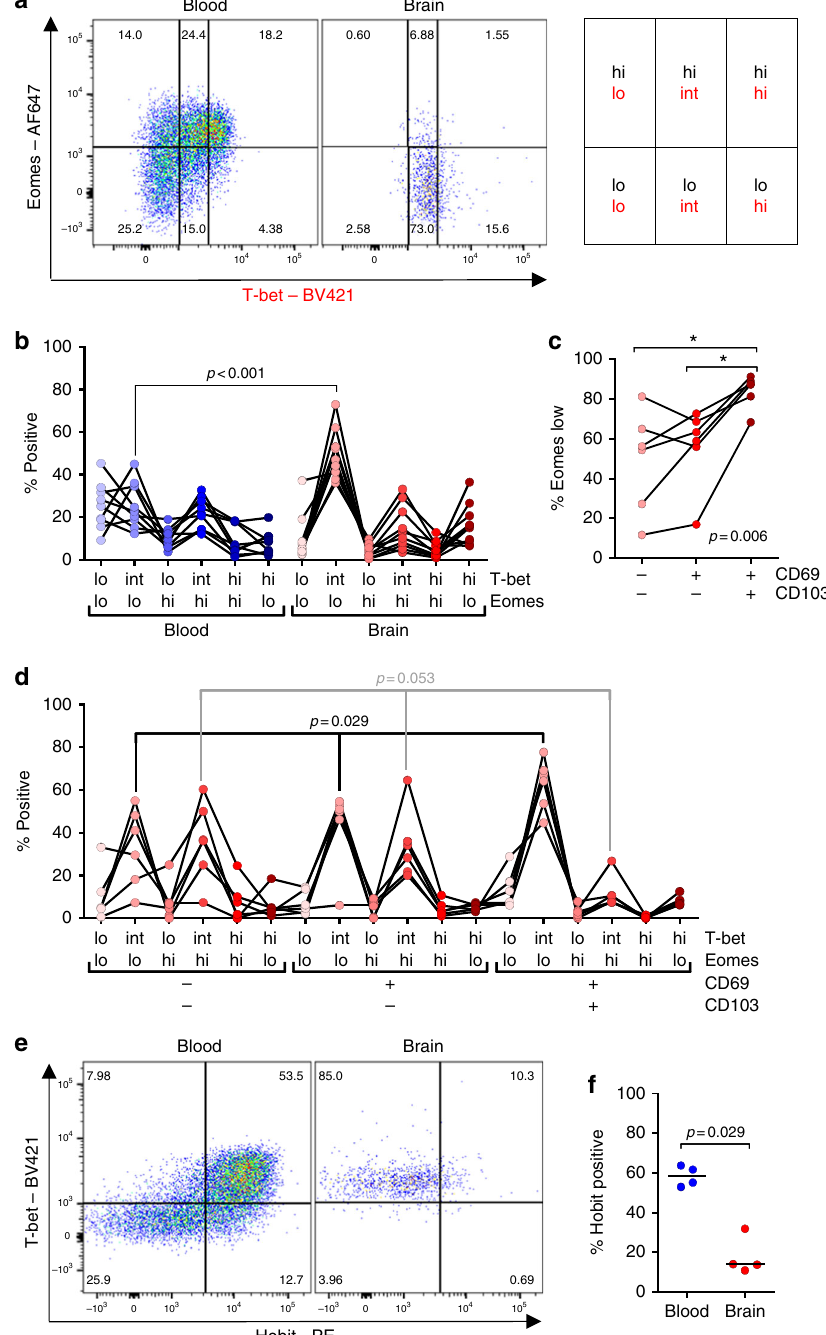
Fig. 5 Human brain CD8 + T cells show a T-bet-intermediate/eomes-low phenotype. a Dot plot showing the gating strategy T-bet and eomes in a paired blood and brain sample. T-bet and eomes co-expression (lo/lo > int/lo > lo/hi> int/hi > hi/hi > hi/lo) correlates in virus-speci fi c CD8 + T-cell with differentiation from central memory to terminally differentiated effector cells, respectively 15 . b Comparison between blood and brain CD8 + T RM cells, and strati fi cation based on CD69 and CD103 co-expression of brain eomes low ( c ) and all T-bet/eomes subsets ( d ). e Dot plot of T-bet and Hobit co- expression by CD8 + T cells from brain and blood of a donor. f Quanti fi cation of Hobit-positive cells is shown. Bars show median values. p -values show Mann – Whitney U test ( b , f ) and Friedman test with Wilcoxon signed ranks as post hoc test ( c , d ) (* p < 0.05, ** p < 0.01); no brackets indicate no signi fi cant